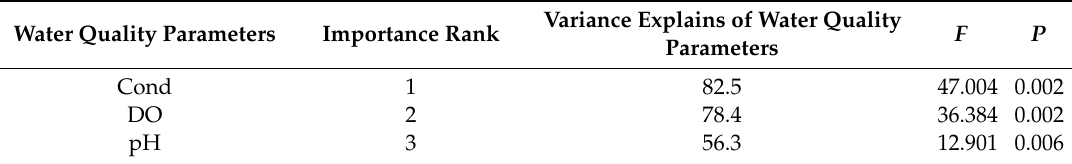
Table 6. Importance and signification level of water quality